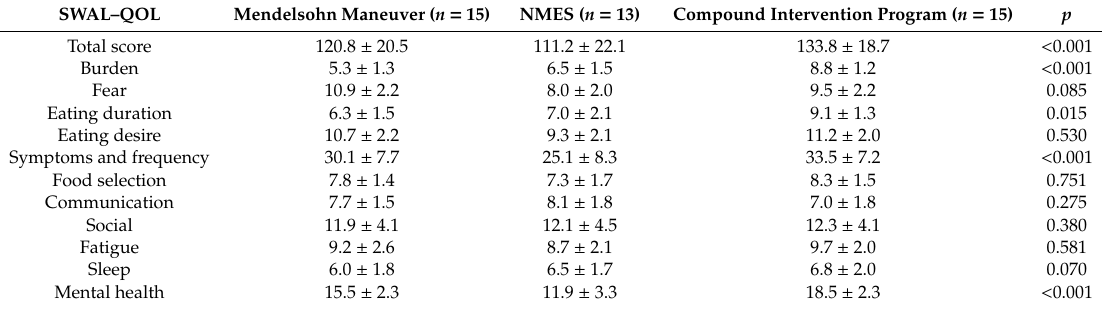
Table 3. SWAL–QOL characteristics of the Mendelsohn intervention group, the NMES group, and the compound intervention group at the baseline, Mean ±